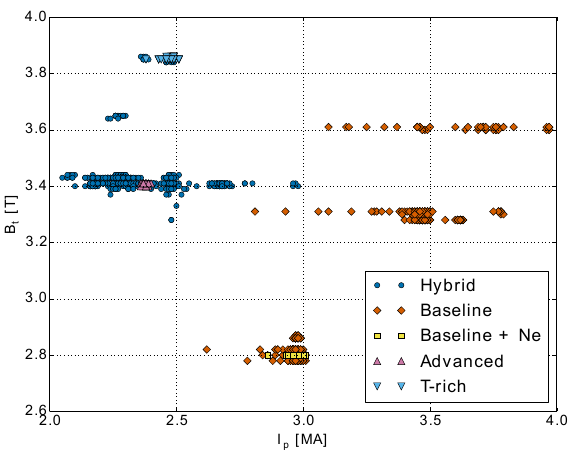
Figure 3: Electron density ( n e ), and temperature ( T e ) of database points corresponding to flat-top phases for each